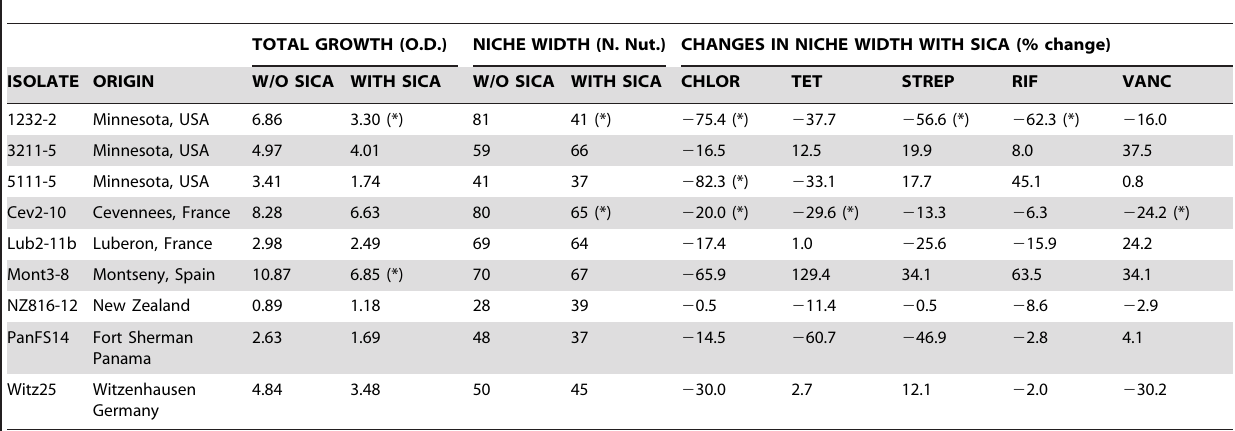
Table 1. Origin, total growth on all nutrients, niche width, and changes in niche width in the presence and absence of SICA.